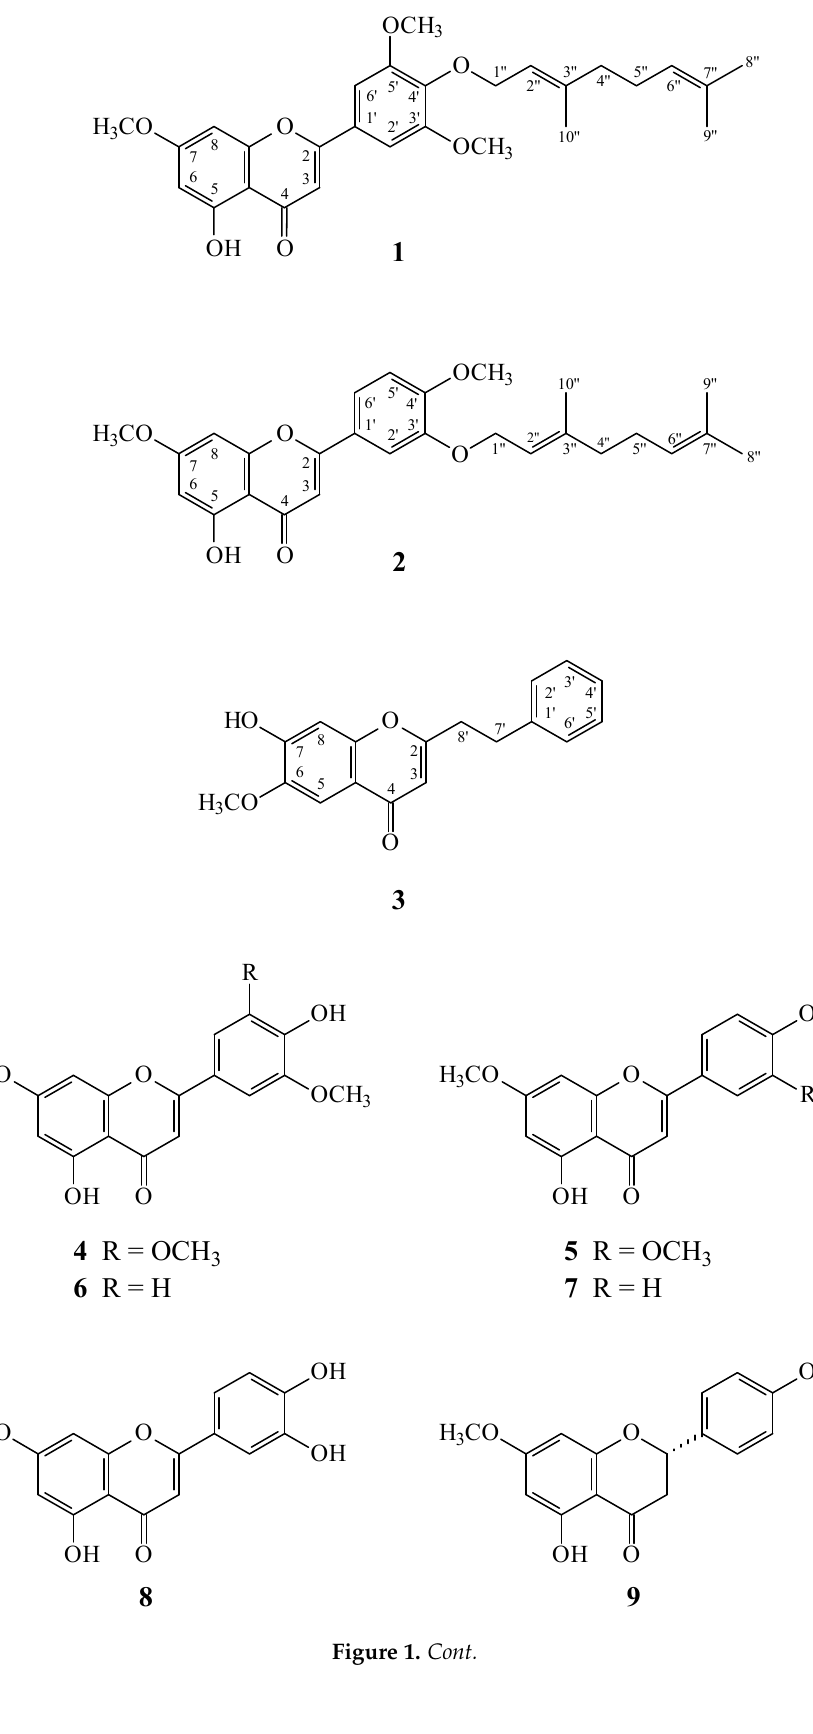
Figure 1. Cont. Figure 1.